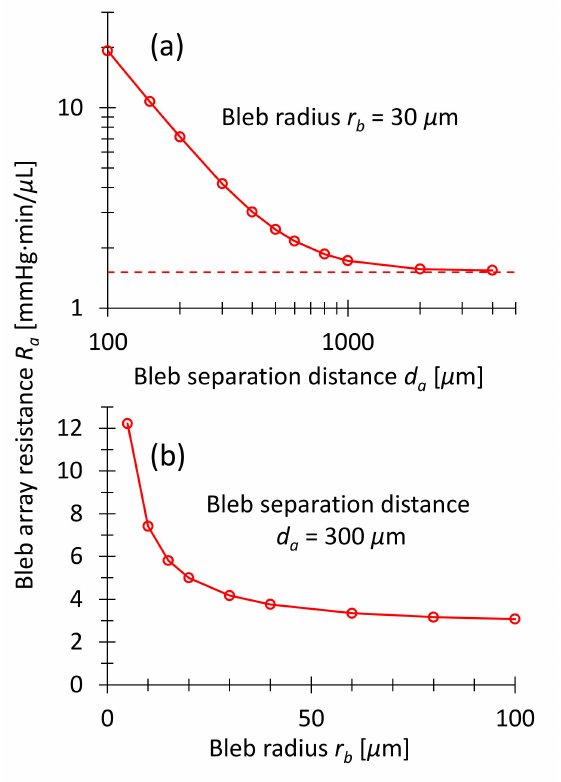
Figure 7. Drainage resistance R a obtained by COMSOL simulations of hexagonal arrays as in Figure 6. ( a ) R a as a function of bleb spacing d a . The bleb radius is constant r b = 30 µ m. The curve reaches the value of 1.5 mmHg min µ for large separations, which is consistent with Equation (13) for free blebs. L ( b ) R a as a function of bleb radius r b . The bleb spacing is constant at d a = 300 µ m. For bleb radii r b > 30 µ m, the curve terminates in a constant value corresponding to the drainage resistance of a shallow macrobleb of 12.6 × 5.2 mm 2 surface